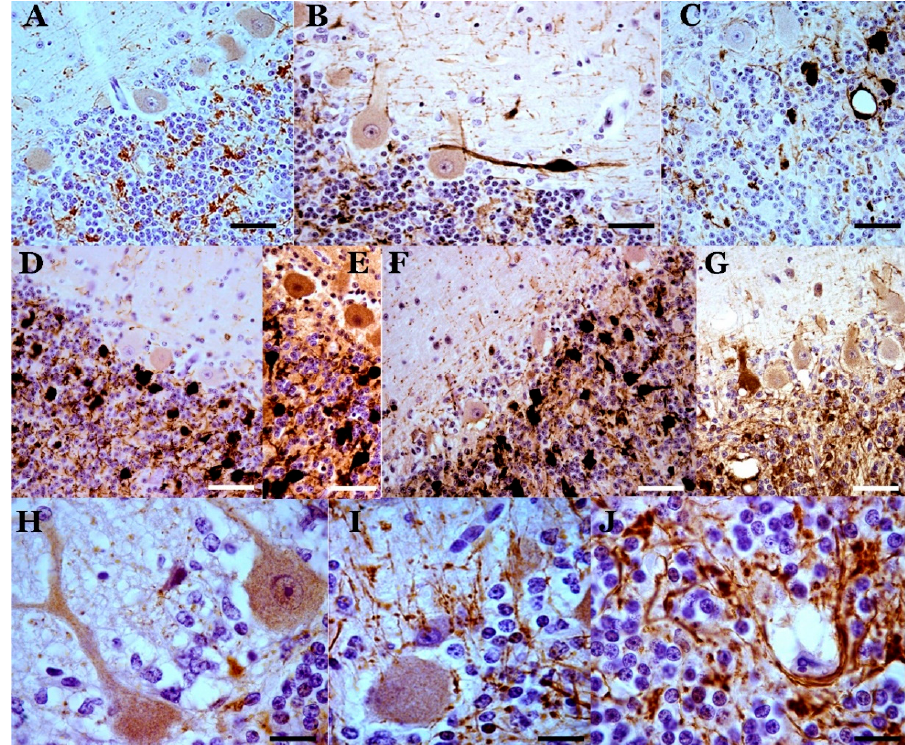
Figure 4. Calretinin-immunopositive cells in the cerebellar cortex of scrapie sheep (hematoxylin contrast). ( A – C ) Lobe VI (neocerebellum). In A, a slight reaction in Purkinje cells (PCs) and a greater intensity in some Golgi and brush cells of the granule cell layer as well as positivity in some parallel fibers are observed in a case of preclinical scrapie, a pattern similar to that shown by healthy controls. In ( B ), a case of clinical scrapie, the reaction pattern is maintained, although the intensity of the reaction is greater in some Purkinje neurons and cells of the granule cell layer (in the image, a Lugaro cell). In ( C ), a case of terminal scrapie, a very intense reaction is seen in hypertrophic Golgi cells of the granule cell layer (a vacuole is surrounded by its dendrites). The number of immunopositive Purkinje cells appears to decrease. ( D – G ) Lobe X (archicerebellum). In ( D ) and ( E ), a great diversity of reactions is observed in Purkinje cells (from negative to slightly positive in ( D ) to strongly positive in ( E ) as well as an intense reactivity in Golgi and brush cells of the granule cell layer. (The cell density of these cell types is 3–5 times higher than those observed in the neocerebellum). The reaction pattern is the same as that shown in control cases. In terminal cases ( F ) , it seems to increase the reactivity in Purkinje cells (some of them are very hyperreactive) and decrease the intensity of the reaction in cells of the granule cell layer. ( G ) Detail of hyperreactive hypertrophic Purkinje cells in a case of clinical scrapie. ( H ) Hypertrophic/hyperreactive PCs in clinical phase. ( I ) Thin calretinin-positive varicose fibers that are prolongations of astrocytes of the granule cell layer to the molecular layer (“Weigert fibers”), observable only in clinical and terminal cases. ( J ) Detail of the elongation of monopolar dendrites and axons of brush cells that form loops in their path between grains and vesicles. Clinical scrapie case. (Bar: A = 40 µ m; B = 25 µ m; C–G = 40 µ m; H–J = 20 µ m). The total number of PC decreased by 13.3 ± 5.1%, and the granule cell layer section area decreased by 14.7 ± 7.1% [11]. However, in selected regions, a dramatic reduction